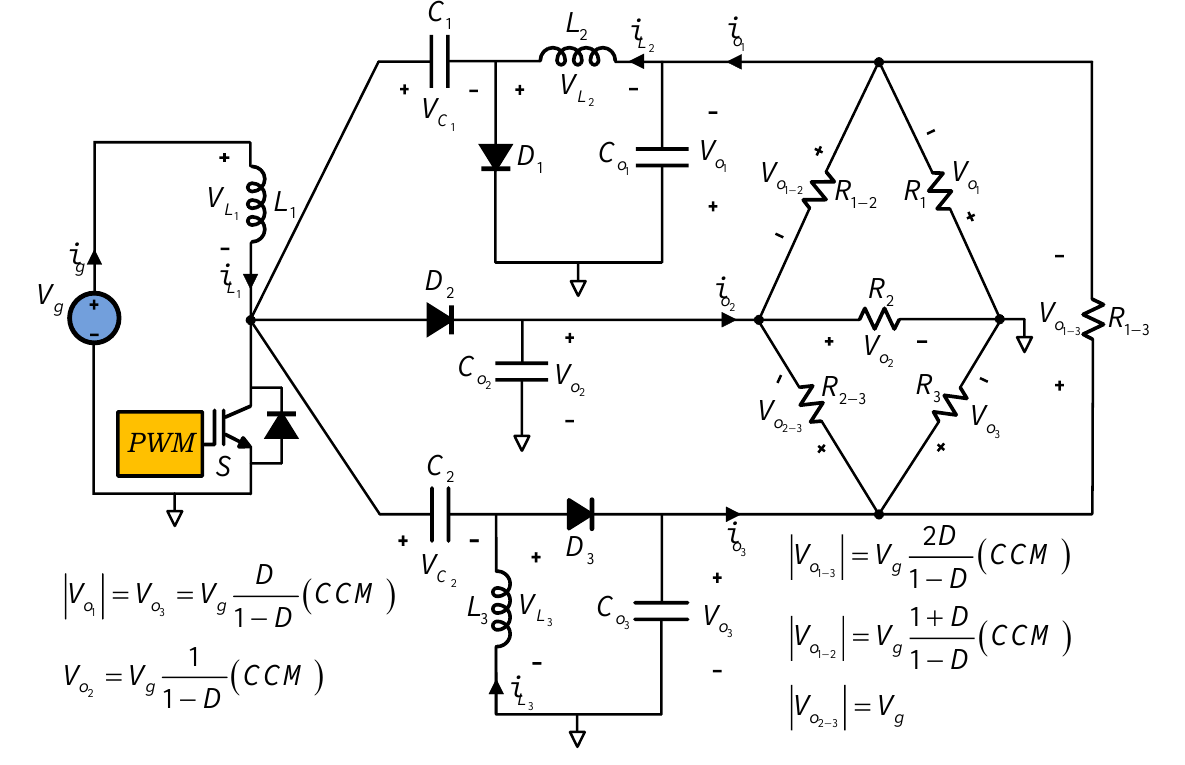
Figure 10. Three-output-type converter combination for six loads. Table 6. Comparative summary of SIMO DC–DC Converters